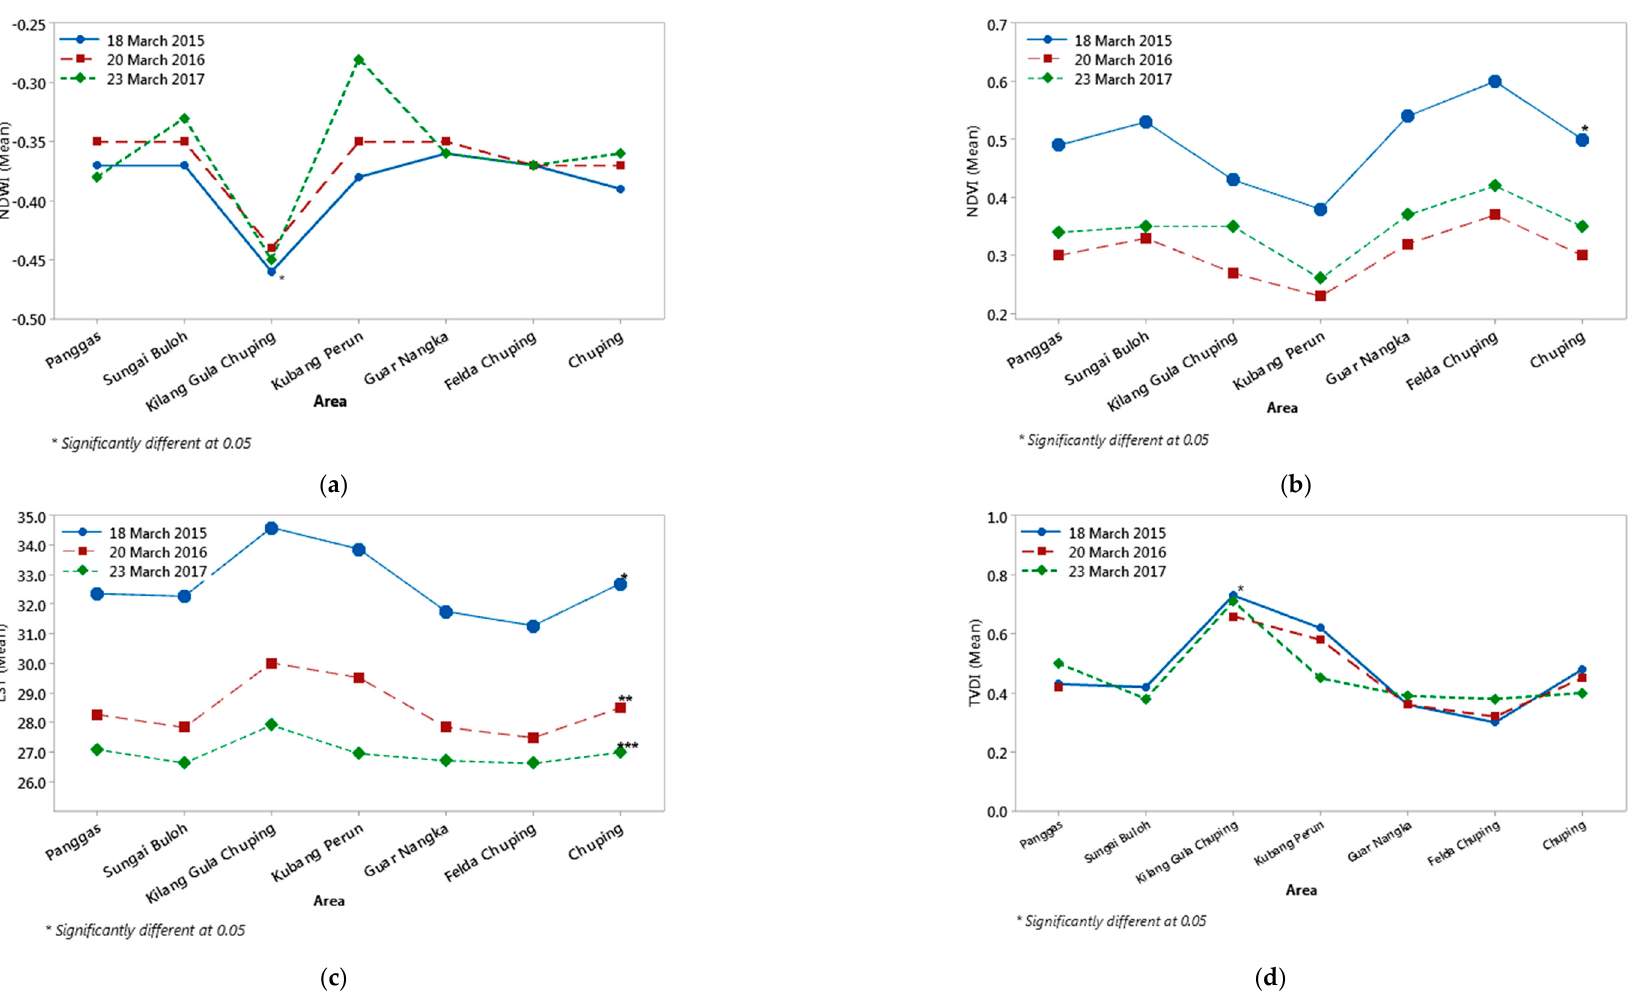
Figure 6. Average values over 3 years (2015–2017) for Chuping, Perlis for the driest months: ( a ) NDWI; ( b ) NDVI; ( c ) LST where 2016 marked with “**” and 2017 marked with “***” shows that over 3 years, the LST significantly different from each other in all the areas and subarea.; ( d ) TVDI.